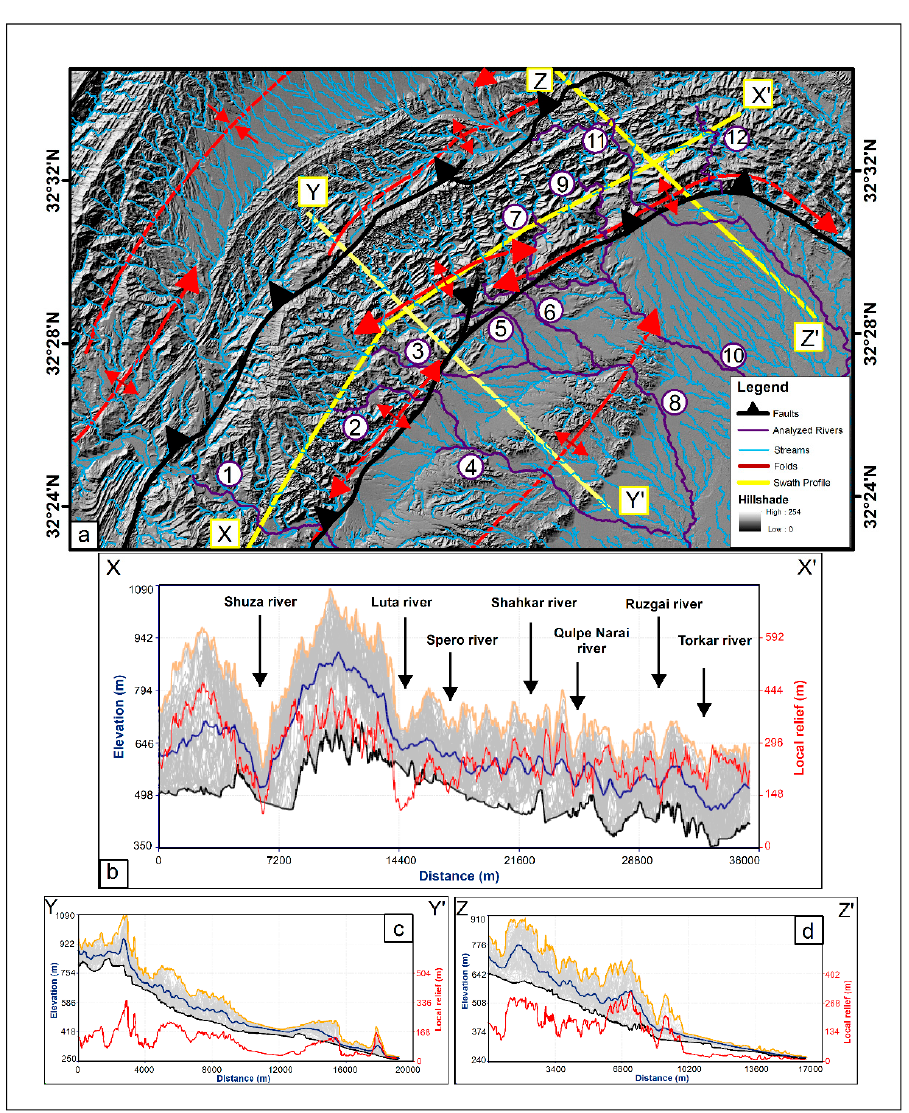
Figure 6. ( a ) Shaded relief image of the Manzai Ranges with the drainage network highlighted in blue. Yellow lines are the traverse and longitudinal swath profiles calculated with a strip width of 4 km. The rivers highlighted in purple are extracted and analyzed for their longitudinal profiles; ( b ) east–west longitudinal swath profile along the frontal anticlines, showing the mean (blue), minimum (black), maximum (orange) elevation, and local relief (red). This shows the higher erosion rate in the highest western part of the profile related to the uplift produced by the frontal thrust; ( c , d ) are the north–south oriented transverse swath profiles. The transverse profiles show asymmetric relief and can be related to neotectonic activity caused by the frontal